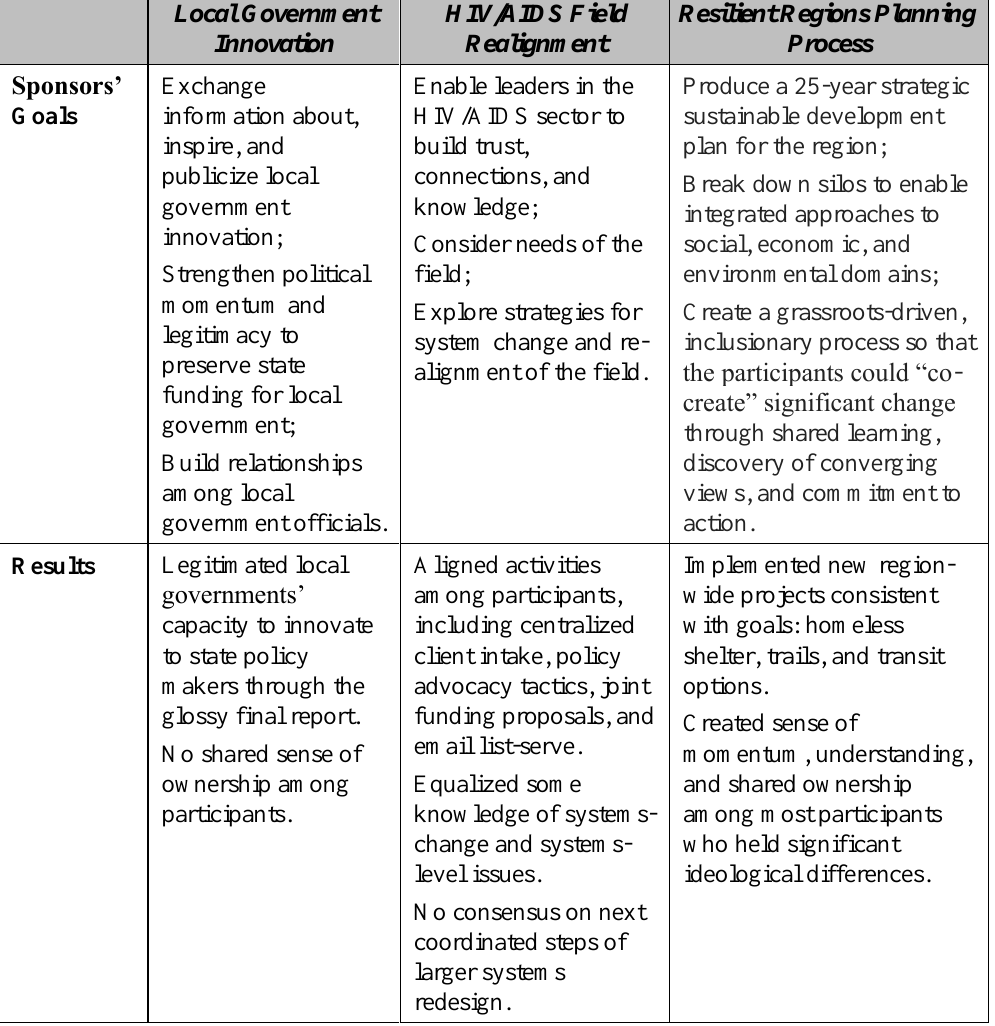
Table 1. Goals and results of deliberative processes in study